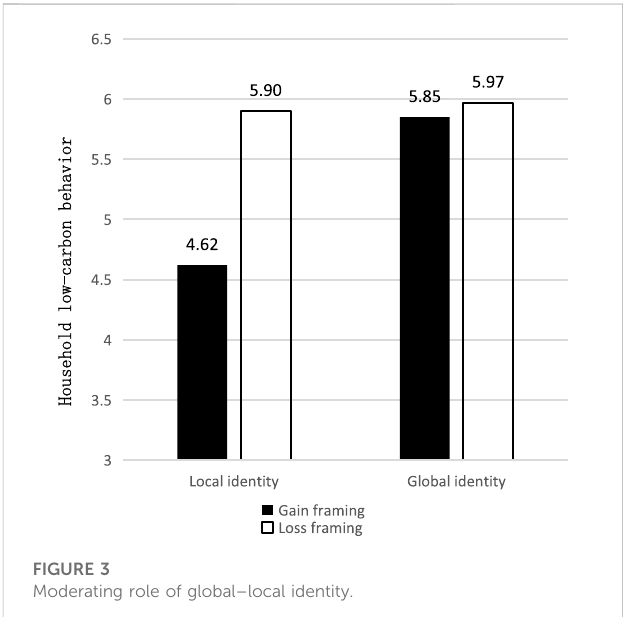
FIGURE 3 Moderating role of global – local